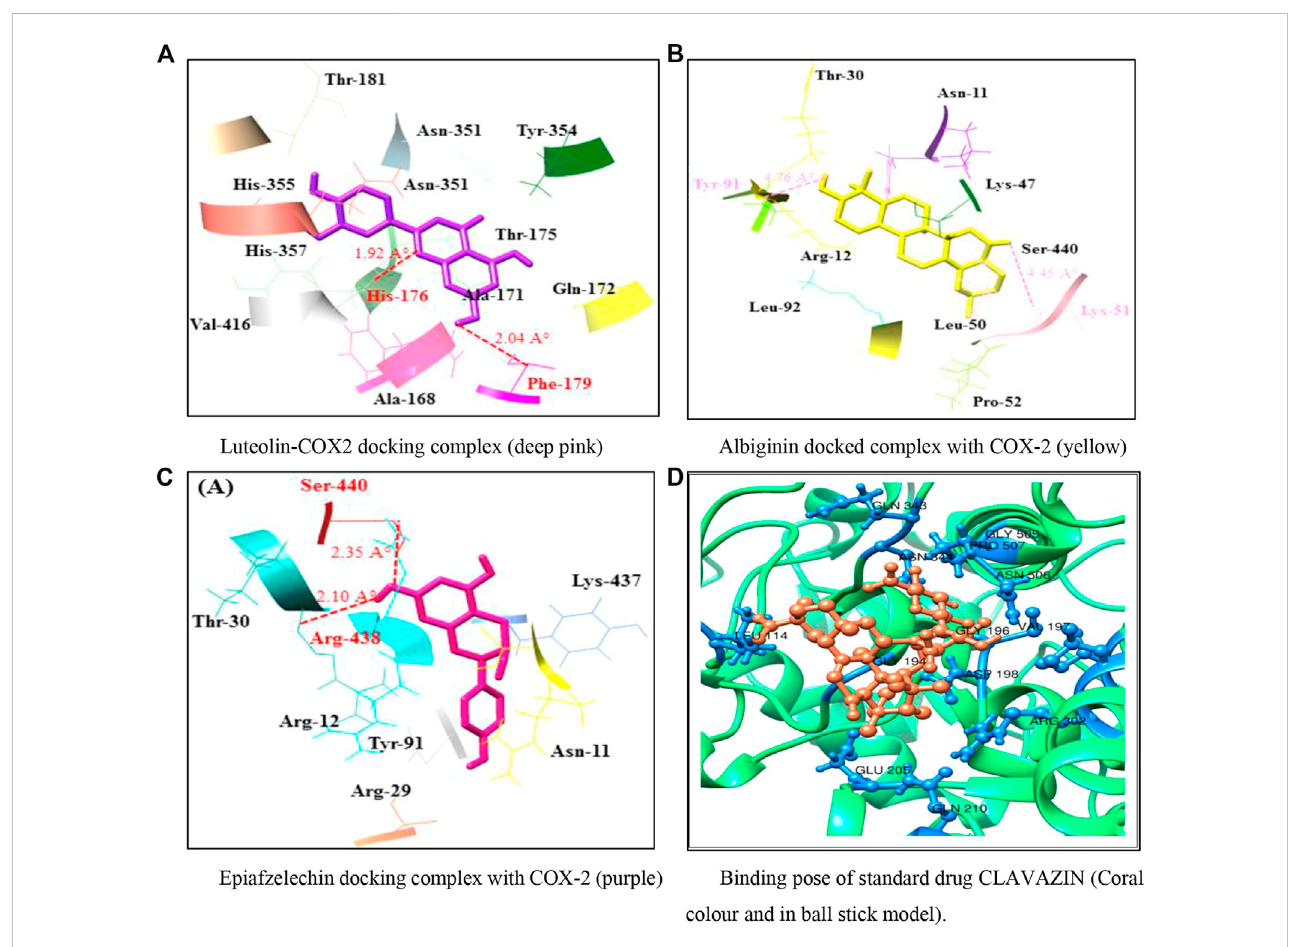
FIGURE 3 (A – D) Docking models representing binding poses of the phytocompounds and standard drug.